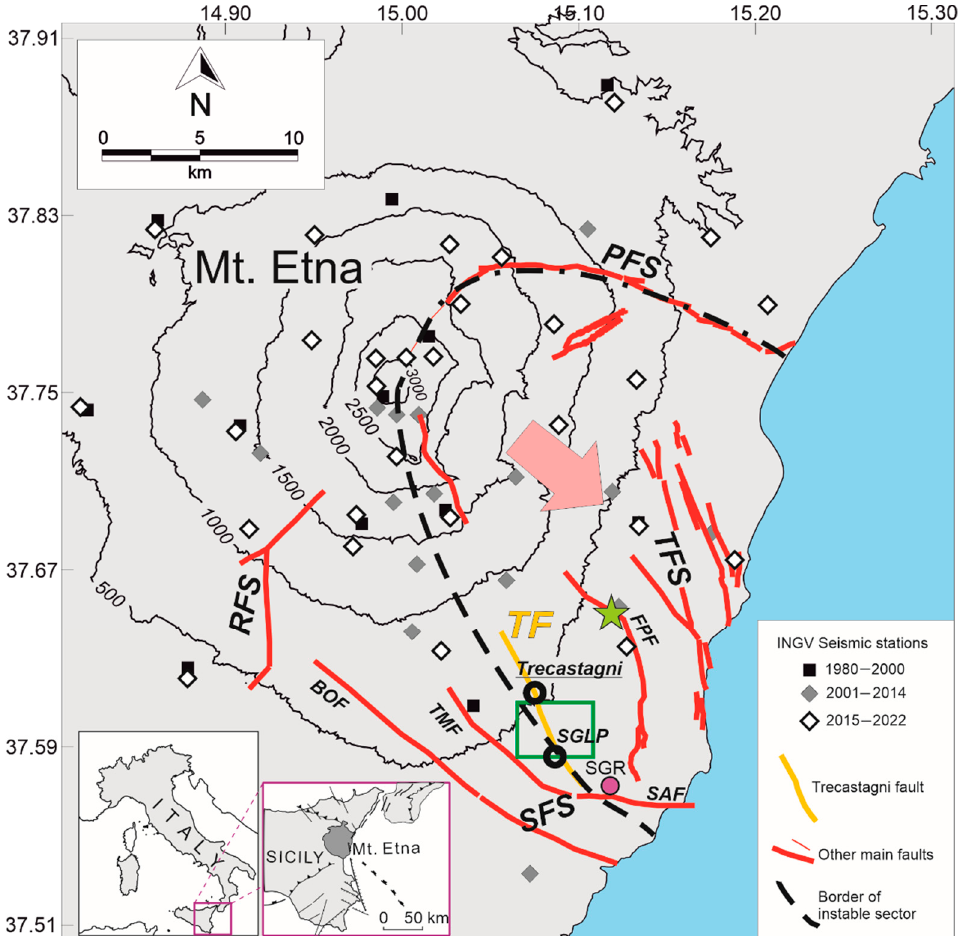
Figure 1. Map of Mt. Etna volcano and main tectonic elements from [34]. TFS: Timpe Faults System; PFS: Pernicana Fault System; TF: Trecastagni Fault; TMF: Tremestieri ‐ Mascalucia Fault; BOF: Belpasso ‐ Ognina Fault; FPF: Fiandaca ‐ Pennisi Fault; SAF: San Gregorio ‐ Acitrezza Fault; SFS: South Fault System; RFS: Ragalna Fault System; SGLP: San Giovanni La Punta. Seismic stations of the permanent (UNI ‐ CT, IIV ‐ CNR, INGV ‐ OE) networks are indicated with black squares and grey and white diamonds, respectively (see text for details). Green star represents the ML = 4.8 earthquake recorded on 26 December 2018. SGR: S. Gregorio seismic station. Pink arrow: direction of sliding. Green square: study area. In the two insets (lower left side), a map of Italy and a schematic structural map of Eastern Sicily.